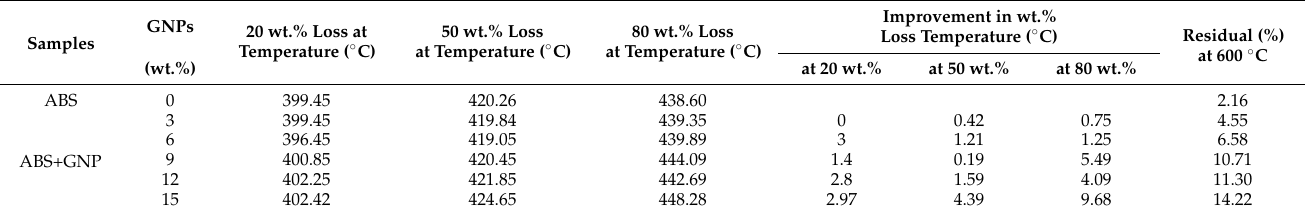
Figure 8. TGA curves of ABS and ABS+GNP nanocomposites. Table 2. Thermal degradation characteristics of neat ABS and ABS+GNP composite films.